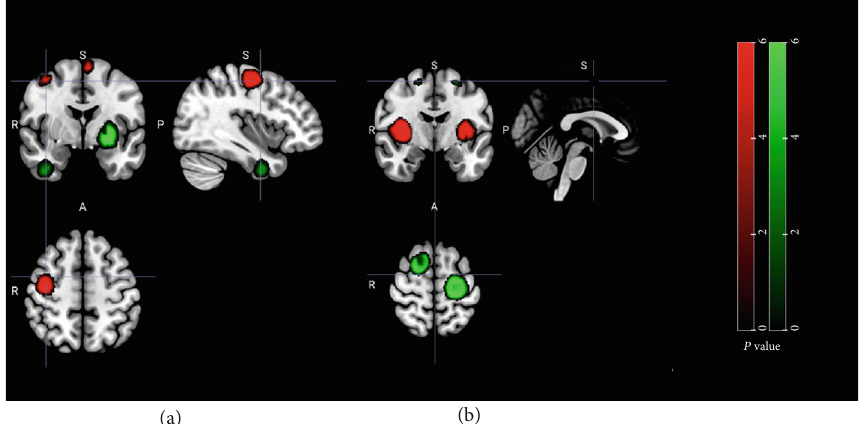
Figure 3: SDM-PSI meta-analysis for (a) ReHo change in poststroke patients after conventional treatment and (b) ReHo change in poststroke patients after acupuncture treatment. Red color refers to hyperactivation, and green color refers to